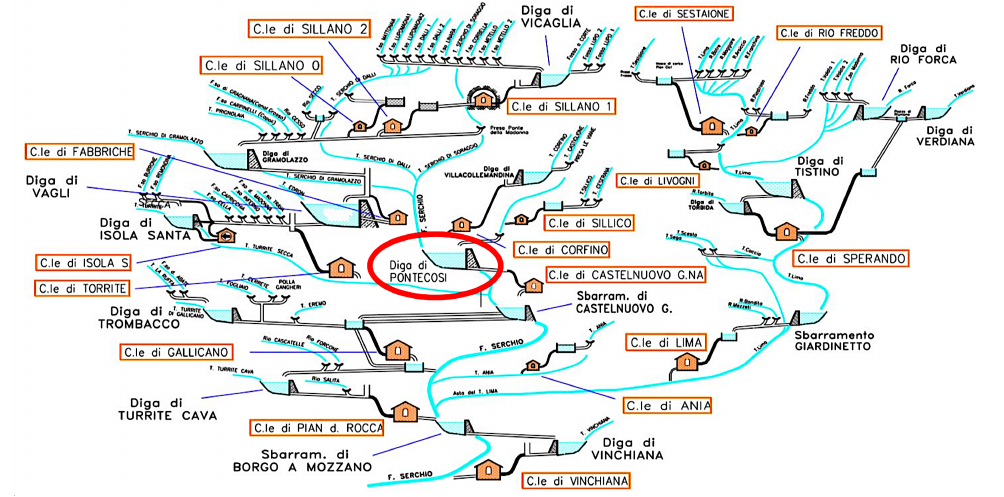
Figure 2. Hydro system in the area of